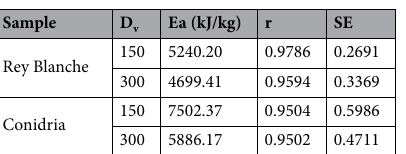
Table 7. Energy of activation and related correlation coefficient for different levels of Air flows